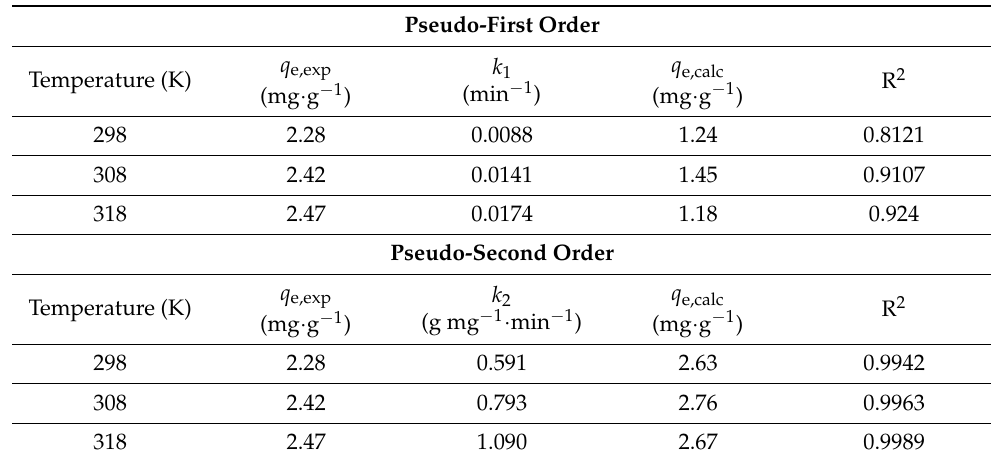
Table 1. Kinetic parameters for the sorption of gold onto the investigated sorbent.